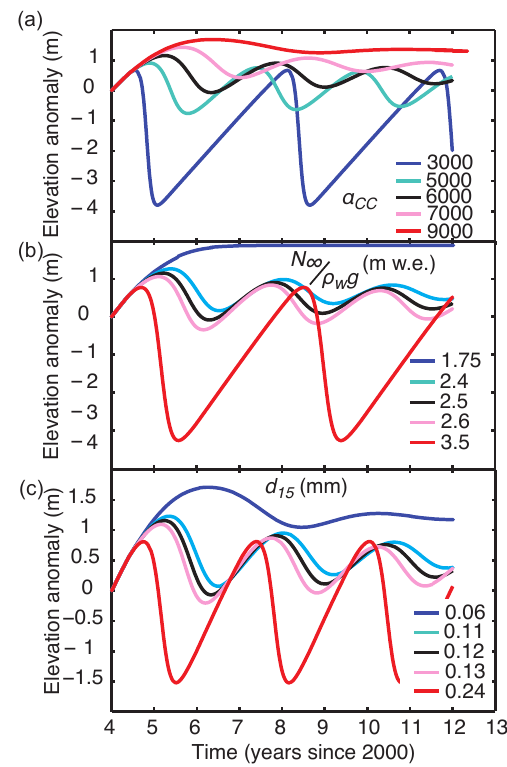
Figure 10. Sensitivity of canal model to sediment and channel prop- erties. Variation of elevation anomaly ( z sL ) due to five different val- ues of (a) channel geometry ( α CC ), (b) sediment effective pressure ( N ∞ ), and (c) mean sediment grain size ( d 15 ). The black lines de- note the “control” run using our preferred parameter values (Ta- ble